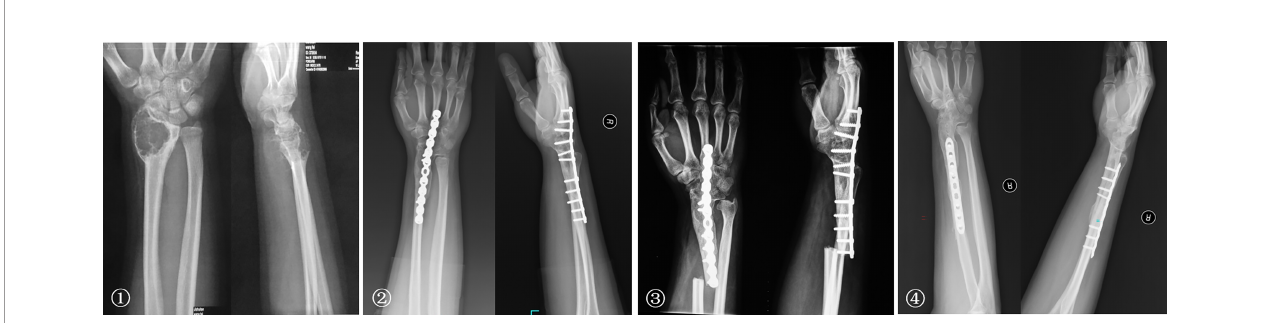
FIGURE 4 | ① The preoperative radiographs of a 29-year-old man with chondrosarcoma. ② Treatment included a distal radius resection and autogenous iliac bone graft with wrist joint fusion. ③ Fracture was caused by trauma eight years after surgery, and internal fi xation was performed again. ④ Rotation function of the forearm is shown 192 months postoperatively.